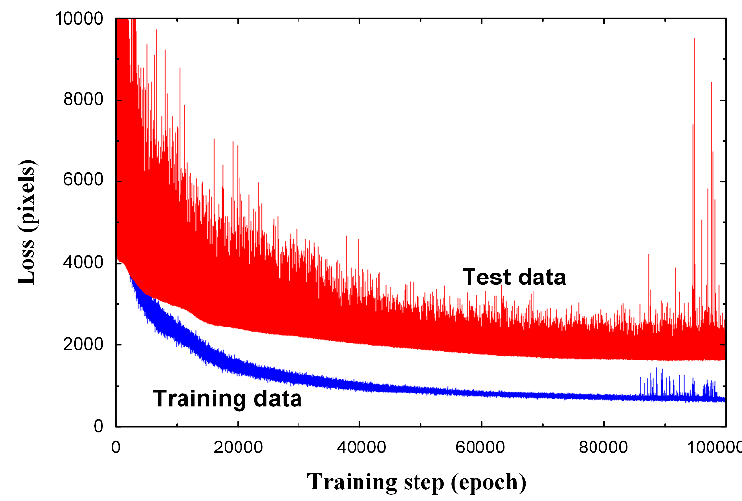
Figure 4. Graph of loss for training and test data during the network training. No overfitting was found up to 80,000 epochs, and high peaks of noise appeared after that. Therefore, the optimum training steps for CNN was determined as 80,000 epochs.